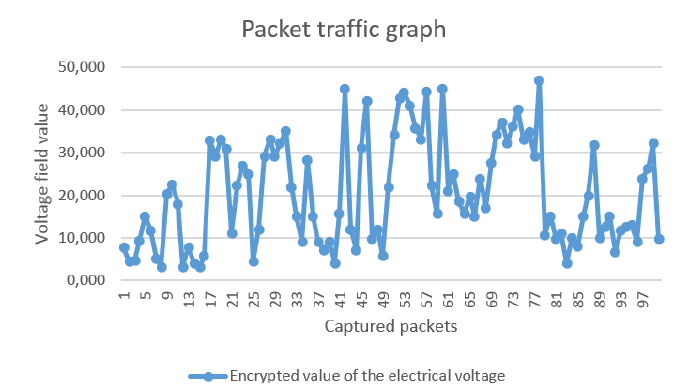
Figure 16. Screenshot of the encrypted responses captured by the WDS